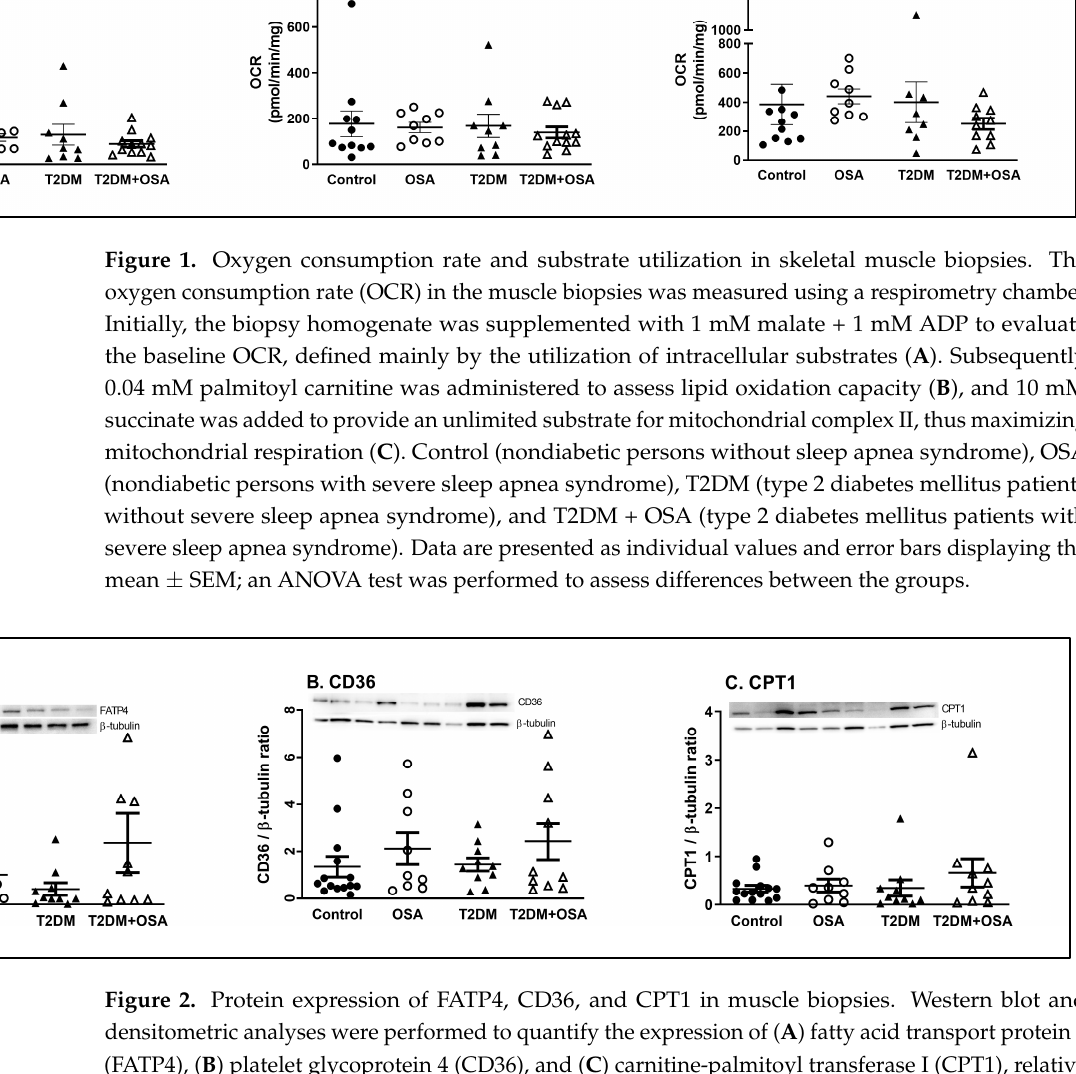
Figure 2. Protein expression of FATP4, CD36, and CPT1 in muscle biopsies. Western blot and den ‐ (FATP4), ( B ) platelet glycoprotein 4 (CD36), and ( C ) carnitine ‐ palmitoyl transferase I (CPT1), rela ‐